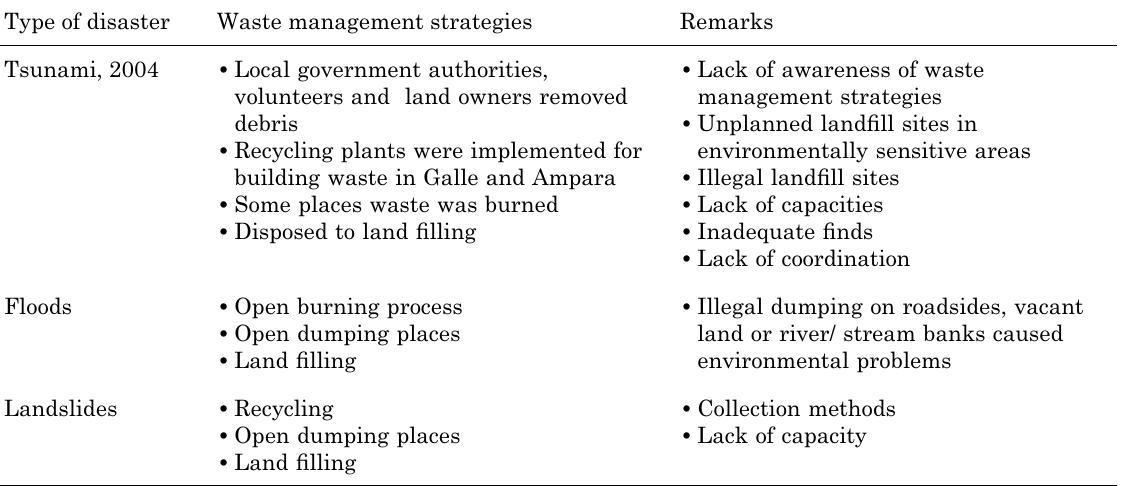
Table 2. Building waste management strategies in local context Type of disaster Waste management